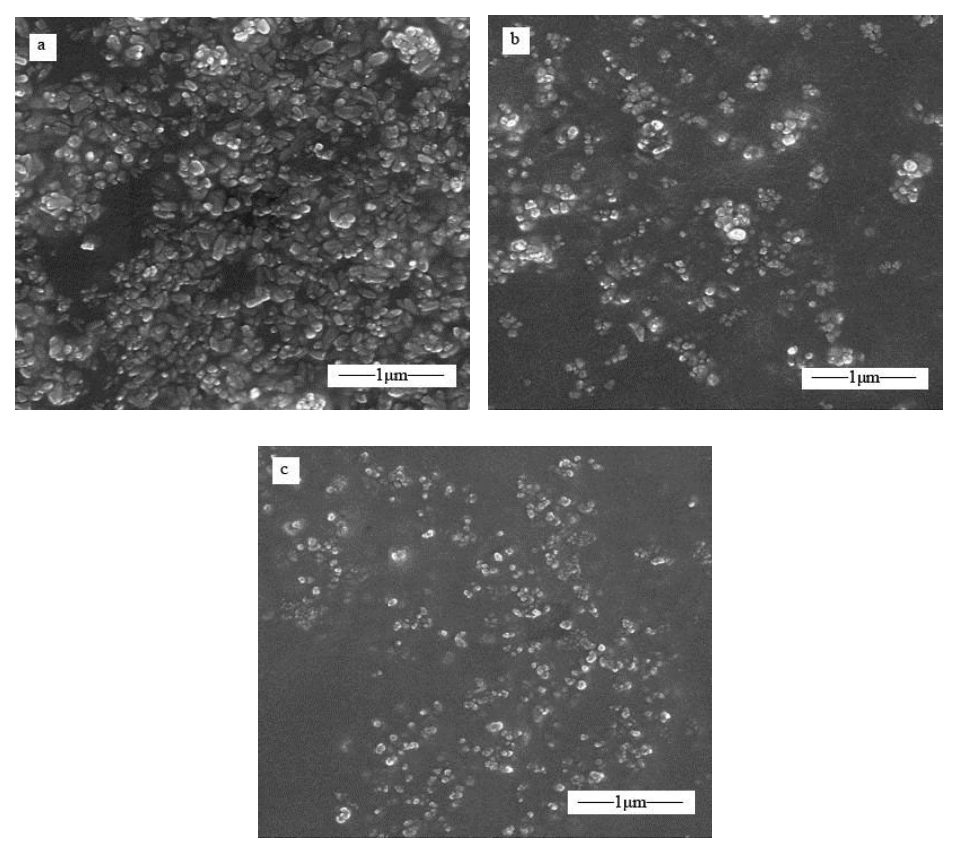
Fig.3 SEM images of nano-ZnO particles Figure 3. SEM images of nano-ZnO particles, unmodified ZnO ( a ), OA–APS–ZnO ( b ), and CDI–OA– Figure 3. SEM images of nano-ZnO particles. APS–ZnO ( c